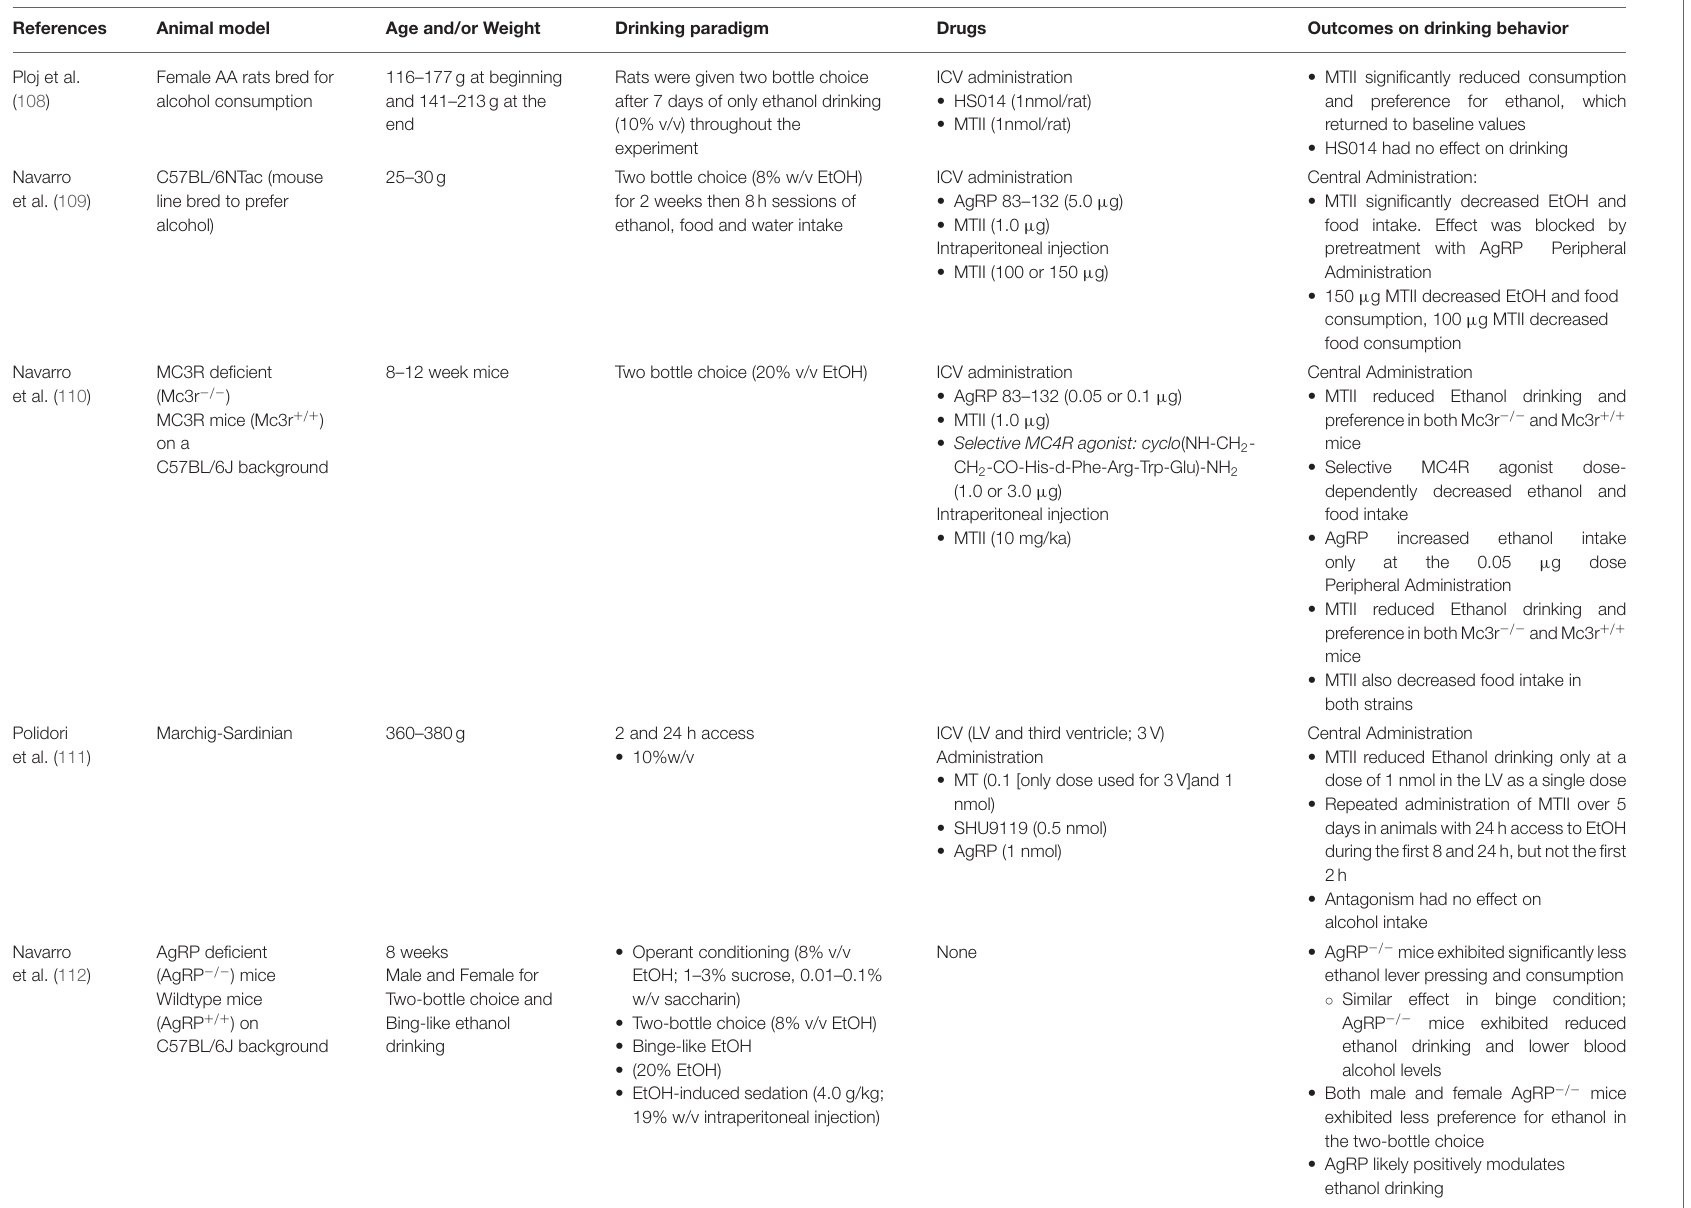
TABLE 2 | Melanocortin system interactions on alcohol